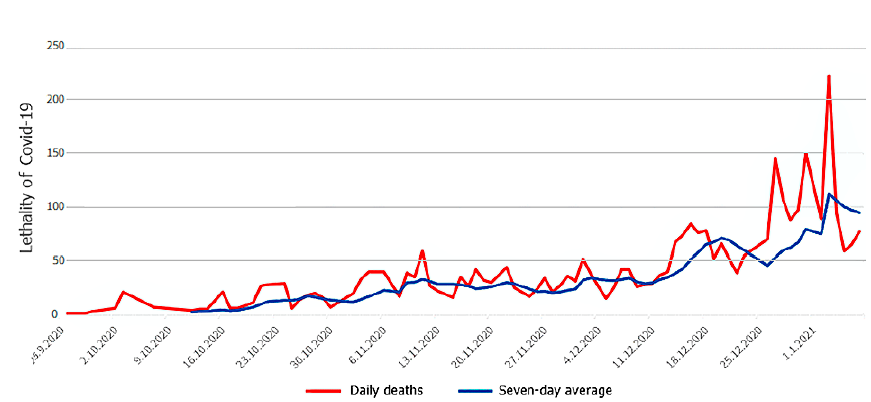
Figure 5. Development of the mortality of Covid-19 Source: Ministry of Health of the SR (2021a)